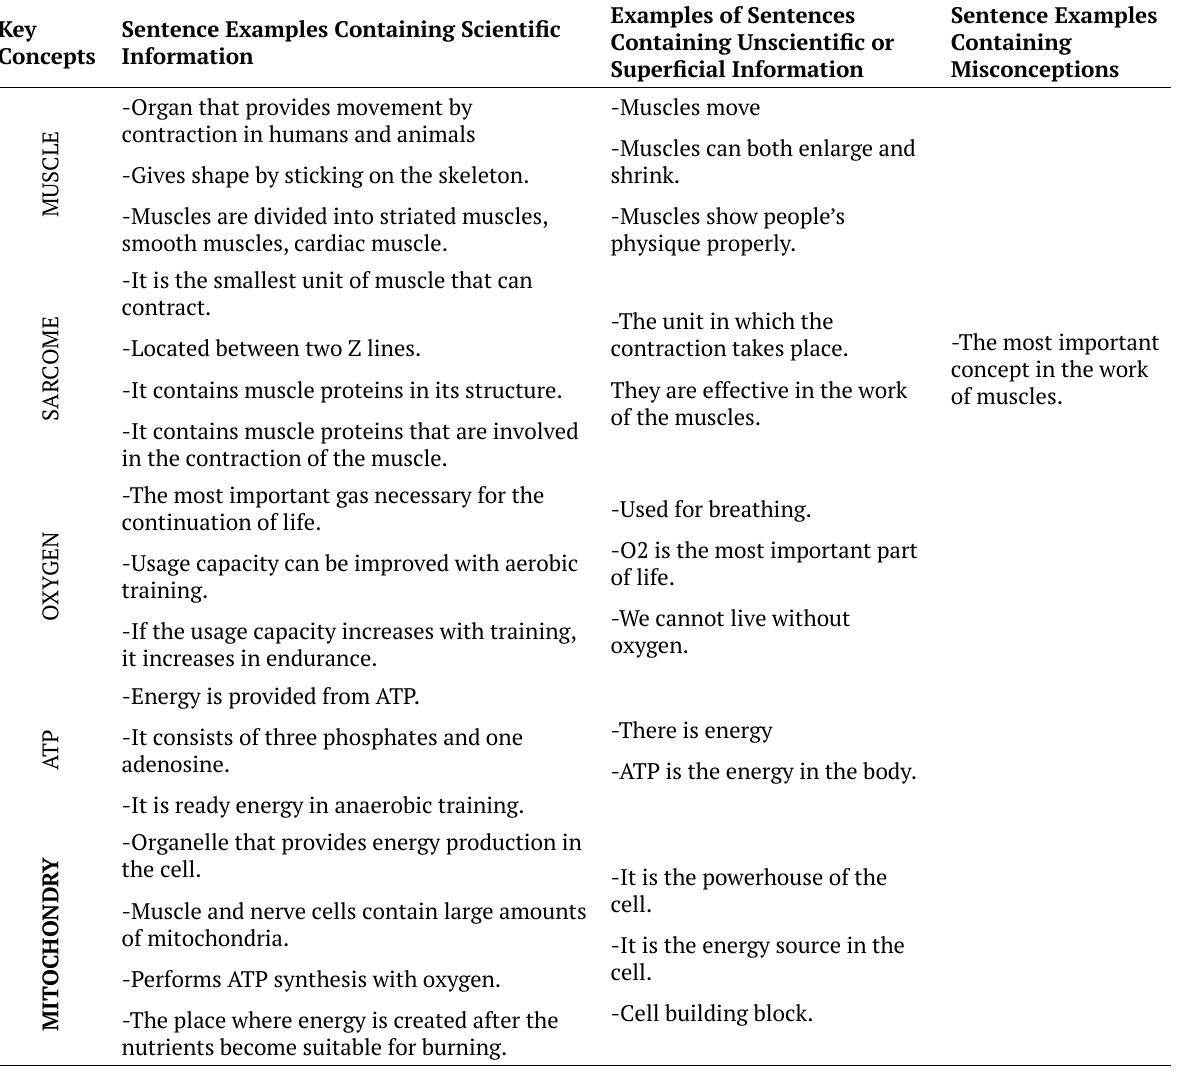
Table 4. Related Sentence Table Given to Key Concepts by Students as a